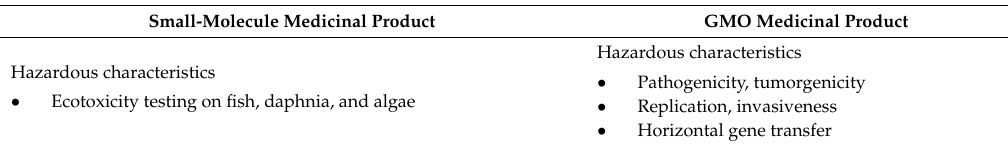
Table 1. Comparison of environmental risk assessments required by the EMA for medicinal products that are small molecules and those that are